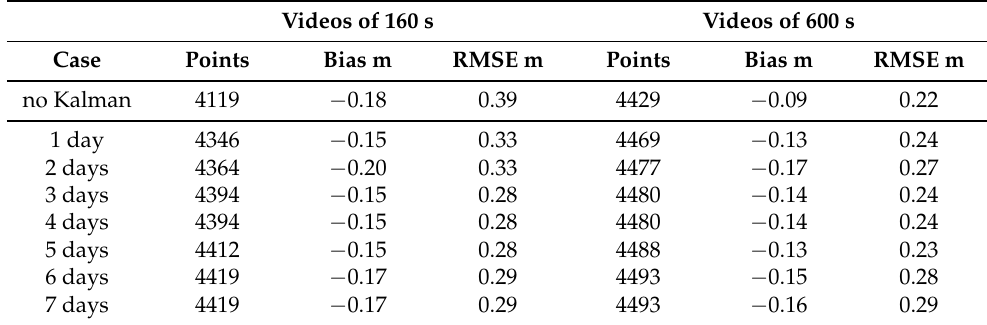
Figure 14. Bathymetry ( top , ( A , B )) and errors ( bottom , ( C , D )) for cropped (160 s) videos without using Kalman ( left , ( A , C )) and using Kalman filter starting 7 days before ( right , ( B , D )) . Table 4. Influence of Kalman filtering using cropped (160 s) and full (600 s)